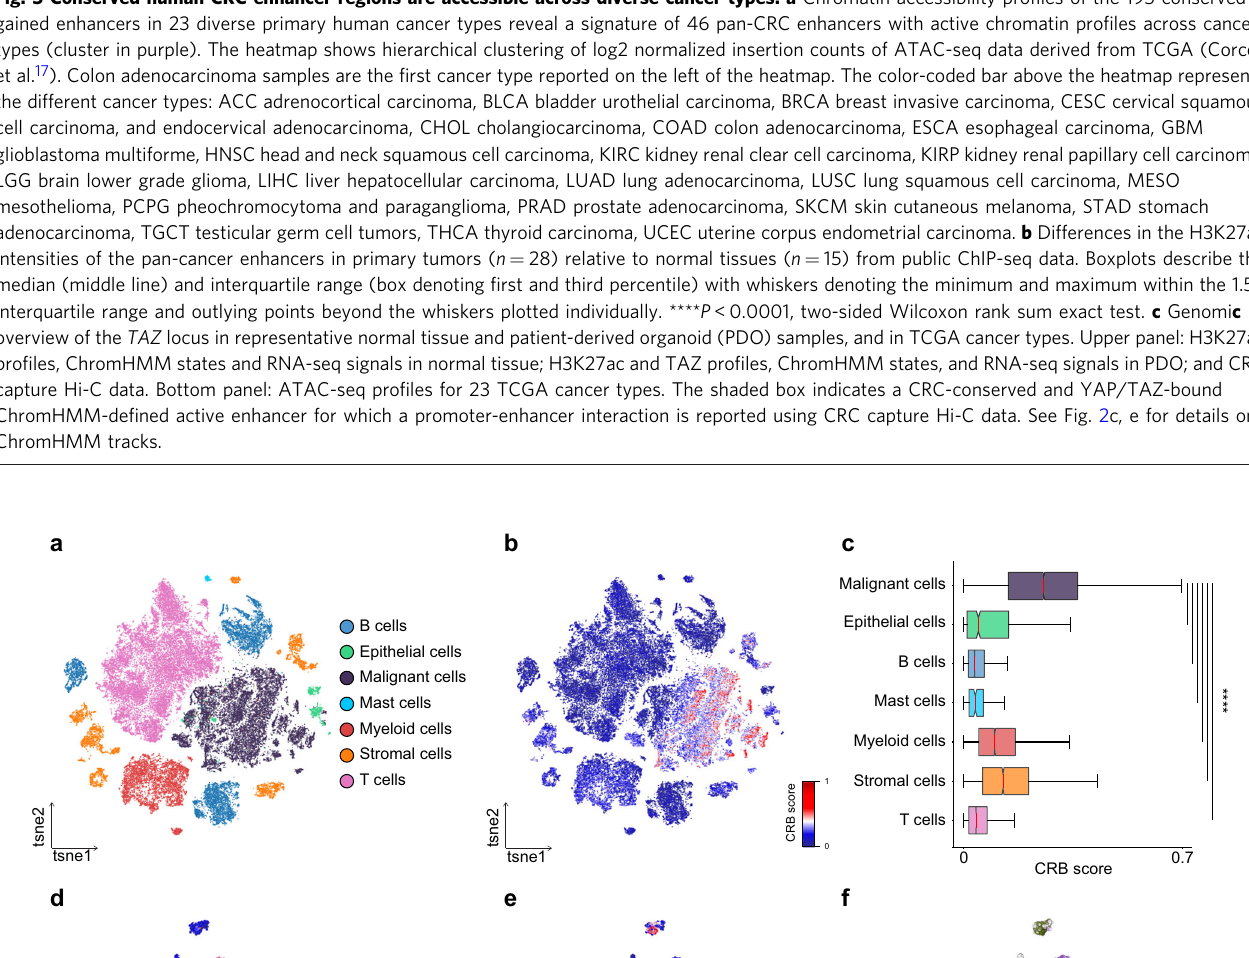
Fig. 6 Distribution of cancer epigenetic deregulation at single-cell level. a t -distributed stochastic neighbor embedding (t-SNE) visualization depicting the major cell types identi fi ed in scRNA-seq data of primary tumor and normal tissues from 23 CRC patients. b t-SNE visualization of the CRB scores across all cell populations. c Malignant cells display signi fi cantly higher CRB scores. Distribution of the CRB score in the malignant (gray; n = 17,469) and non- malignant epithelial clusters (green; n = 1070), and in all other major cell populations (B cells n = 9146; Mast cells n = 187; Myeloid cells n = 6769; Stromal cells n = 5933; T cells n = 23,115). Boxplots describe the median (middle line) and interquartile range (box denoting fi rst and third percentile) with whiskers denoting the minimum and maximum within the 1.5× interquartile range. **** P < 0.0001, two-sided Mann – Whitney U test. d – e t-SNE representation of the CRB ( d ) and stemness ( e ) scores across 18,539 epithelial cells. Contour lines denote normal epithelial cells. f The cancer regulatory blueprint does not relate to stemness. t-SNE representation of the difference between the CRB and stemness score across all epithelial cells. Cells depicted in gray display similar levels of the two scores, whereas cells in purple and green display mutually exclusive high levels of CRB or stemness, respectively. Contour lines denote normal epithelial